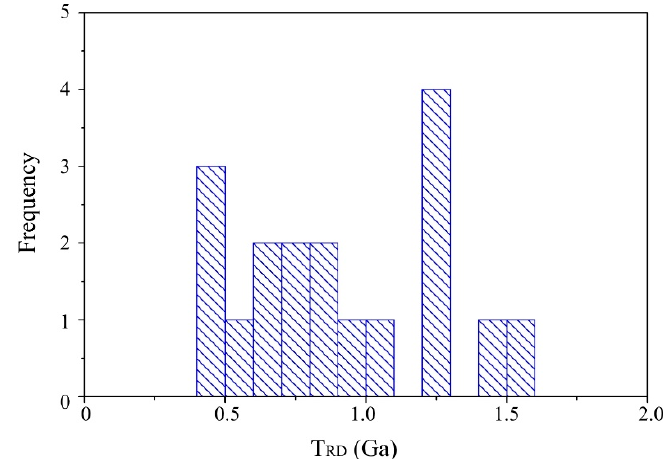
Figure 12. Histogram of mantle-depletion (T RD ) ages of Ru-Os sulfides at